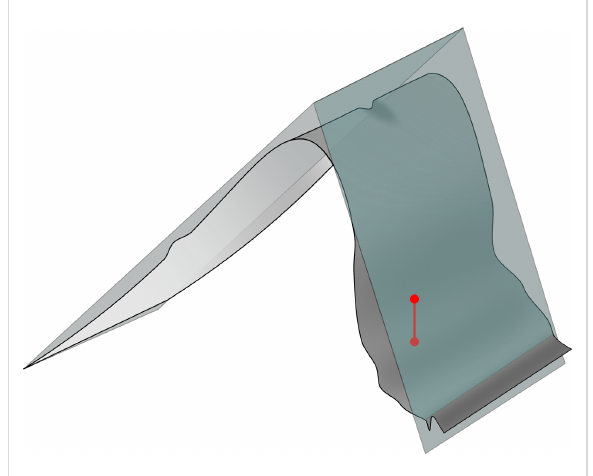
Figure 3: 3D sketch of a real saw-tooth copy compared to its theoreti- cal master. The vertical difference between the mesh points of these two curves (red segment) is used to evaluate RMS.